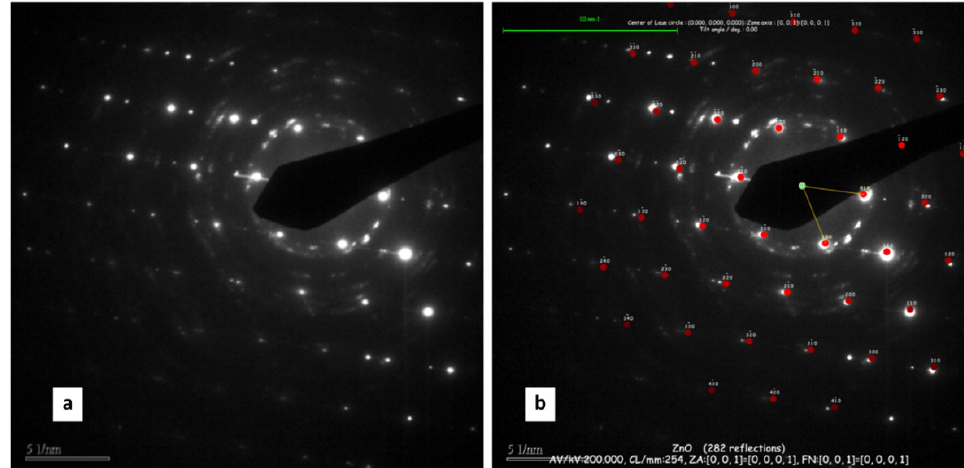
Figure 7. ( a ) Selected area electron diffraction (SAED) pattern of an NW from sample A; ( b ) JEMS fitting of diffraction pattern; Quasi-[0, 0, 1] zone axis of hexagonal ZnO.